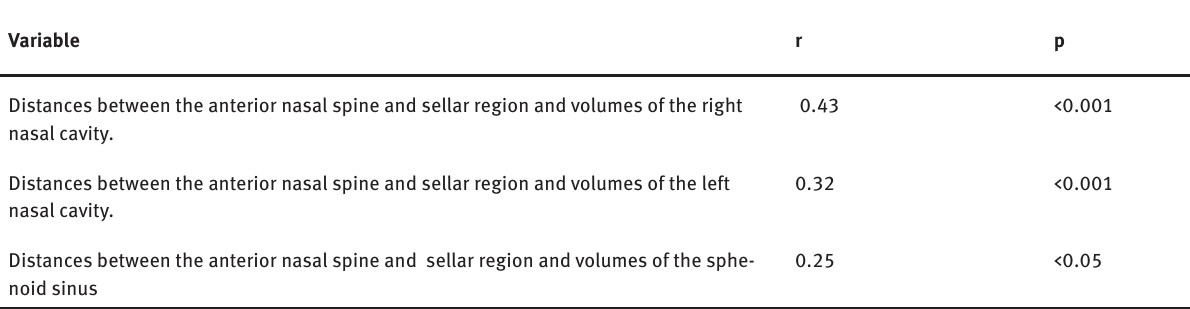
Table 3: Pearson correlation coefficients for distances and volumes (n = 120).